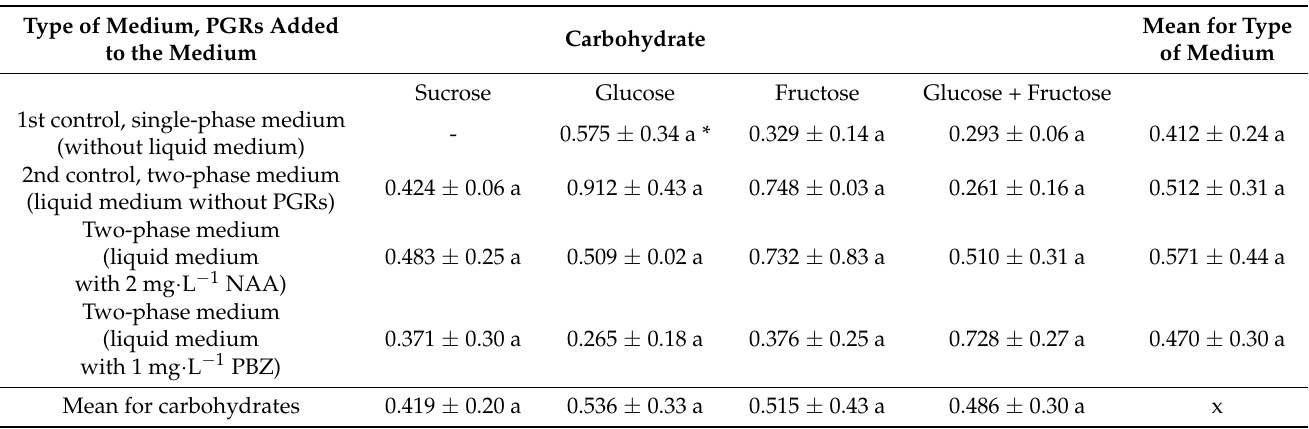
Table 6. Effects of type of medium and plant growth regulators (PGRs) and the after effect of different carbohydrates on fresh weight (g) of mature bulbs of the tulip cultivar ‘Heart of Warsaw’ formed in